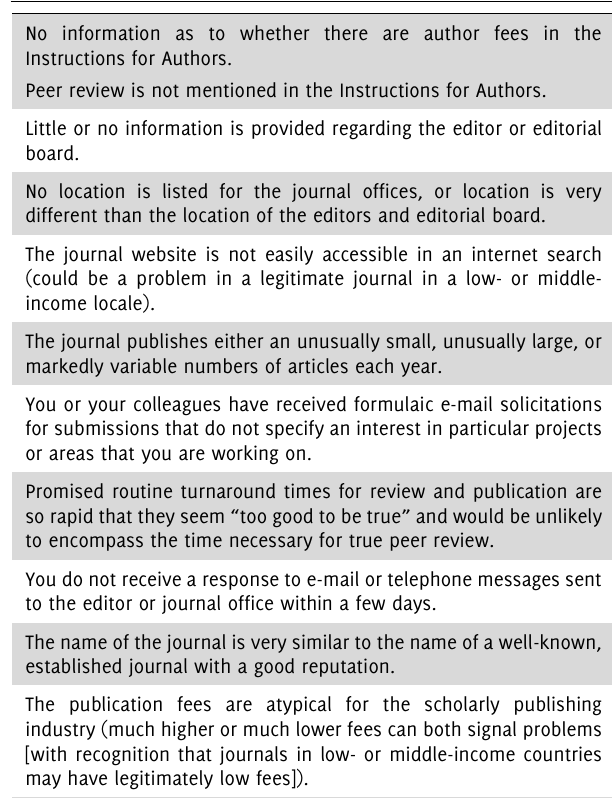
Table 1. “Warning Sign” features that should increase suspicion that a journal is